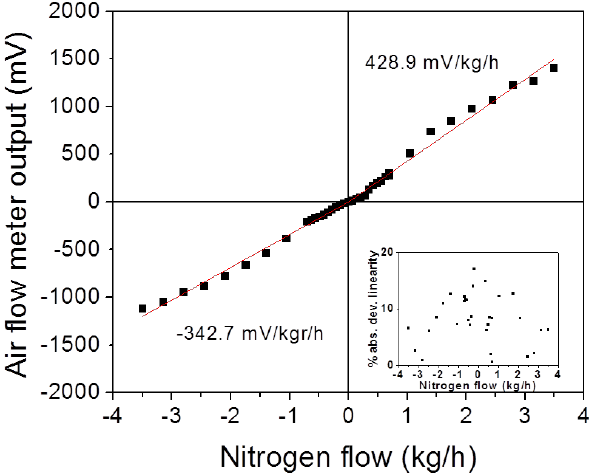
Figure 6. Calibration curve of the air flow meter under nitrogen flow in forward and reverse flow directions, depicting quite symmetrical behavior in both directions. The points are the experimental results, while the red lines represent the linear fit to these points. The air flow meter response is remarkably linear with flow. The inset shows the absolute percent deviation from linearity for all data points. The deviation is less than 18% for all data